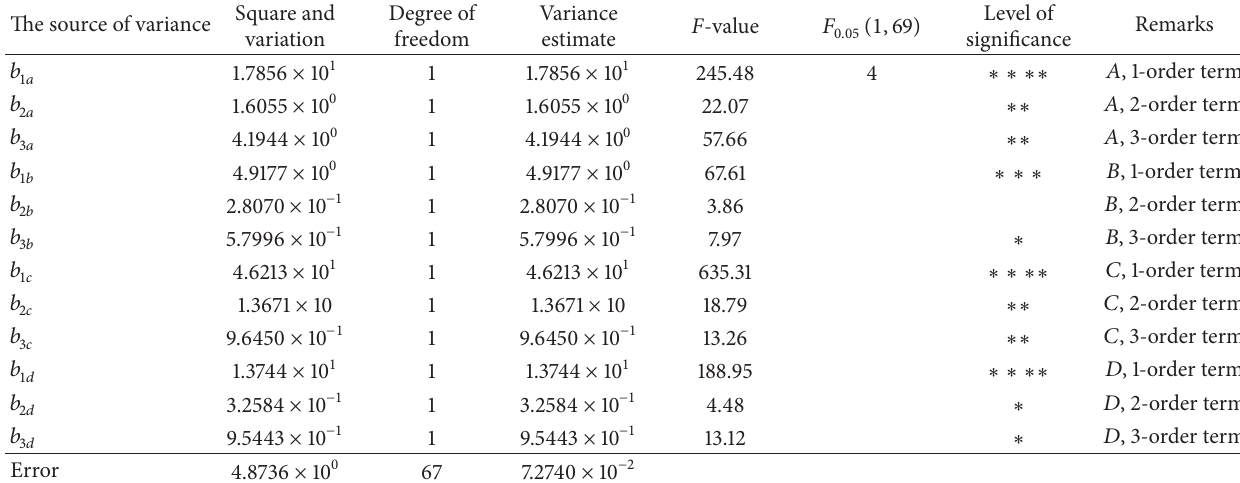
Table 8: Orthogonal polynomial regression analysis of variance: compressive strength index. Square and The source of variance